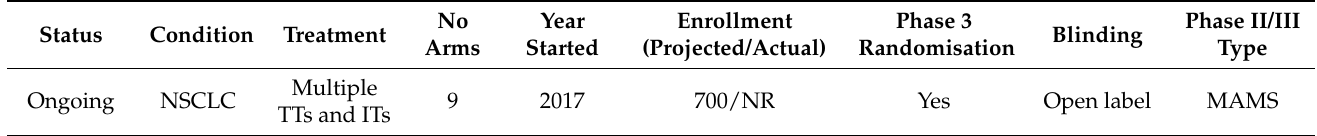
Table 4. Multi-Arm Multi Stage (MAMS) phase II/III